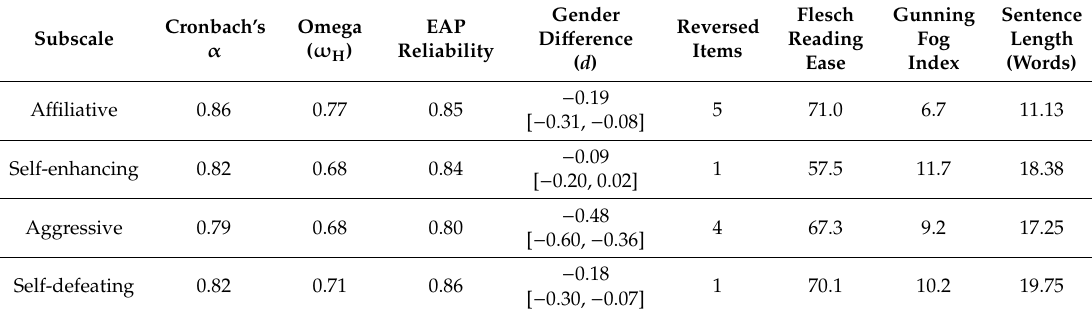
Table 2. Humor Styles Questionnaire (HSQ) subscale